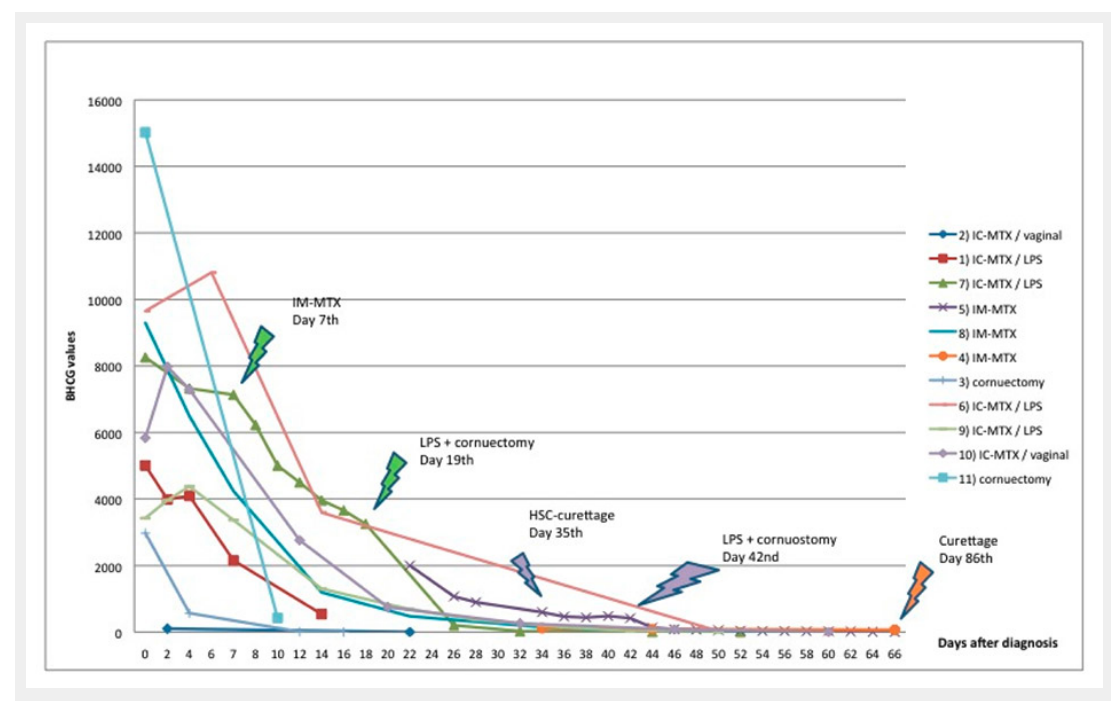
Figure 3 Beta-HCG level follow up after first, second and third line therapies.